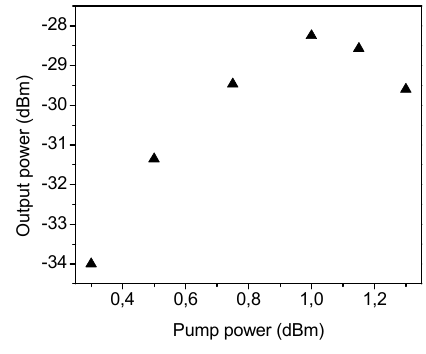
Figure 13. Evolution of laser power vs. Raman pump